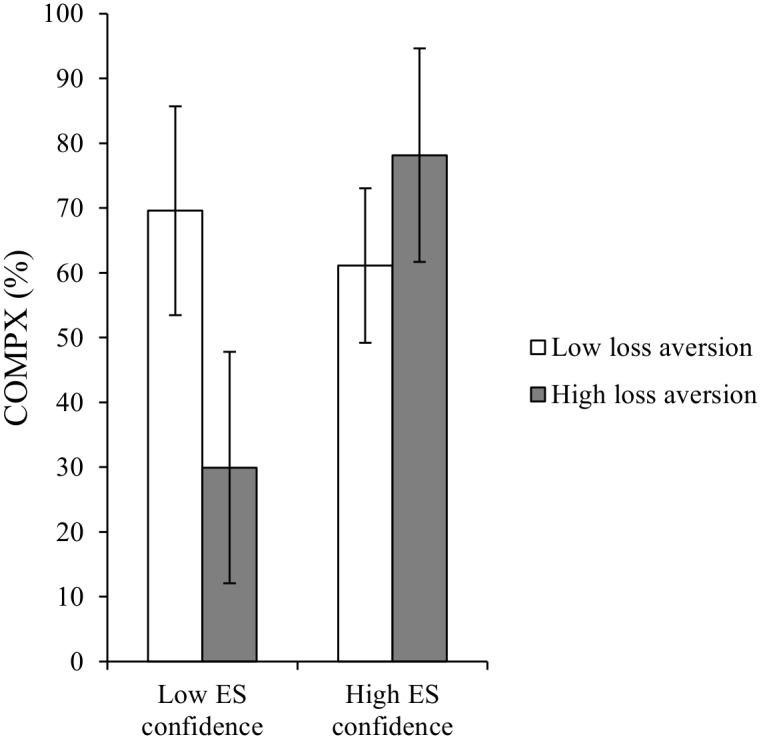
Mean COMPX scores where participants are split by high and low loss aversion and high and low expected-satiation (ES) confidence.Adjusted means were derived from analyses where median splits were taken of the loss aversion and expected-satiation confidence predictors.